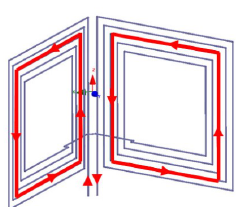
coil was supplied through the single power source obtaining maximum efficiency.